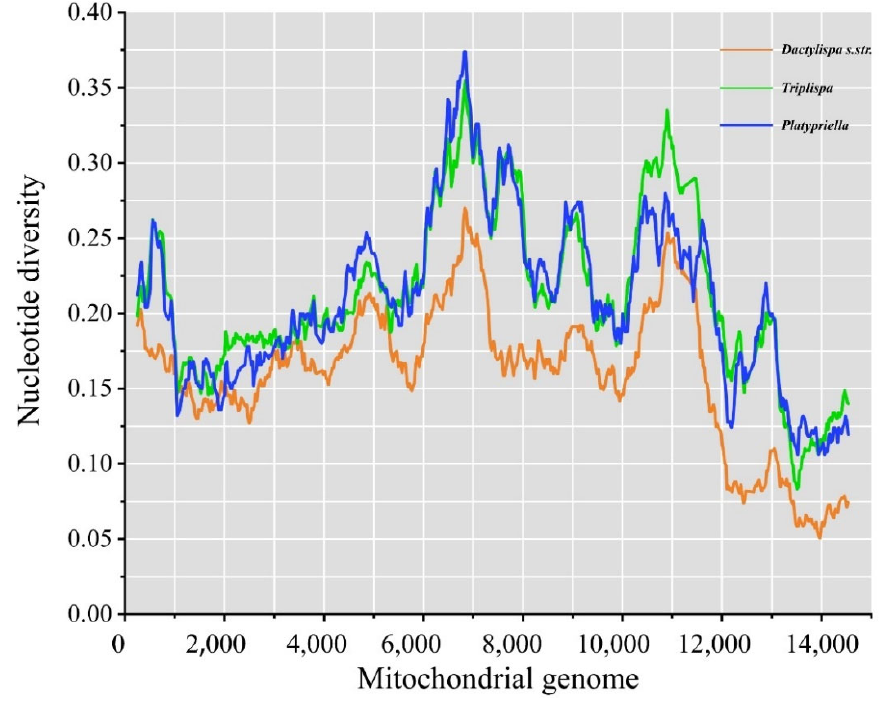
Figure 5. Sliding window analysis of 37 coding genes among 3 Dactylispa subgenera. The lines